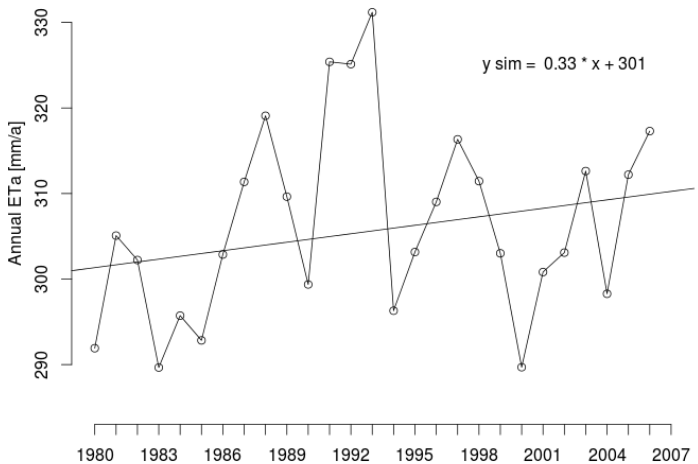
Figure 10. Simulated annual evapotranspiration (ETa) for the Brunau catchment, plus linear trend (y sim = simulated ETa; x = year—1979).